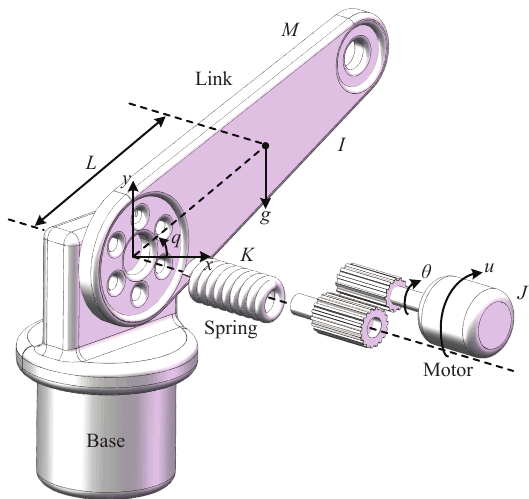
Figure 1. Physical model of a single-link